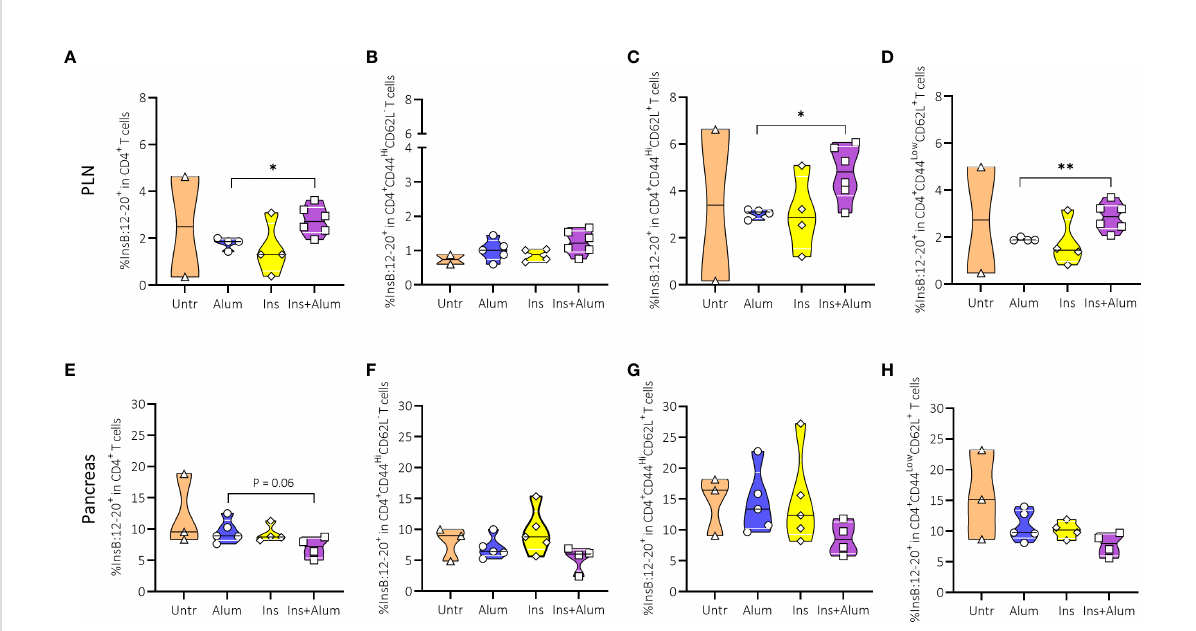
FIGURE 4 Effect of therapy on InsB:12-20-speci fi c CD4 + T cells and InsB:12-20-reactive effector memory, central memory, and naïve CD4 + T cells. Frequencies of InsB:12-20-reactive cells within the CD4 + T cell population (A, E) , CD44 high CD62L - (EM) CD4 + T cells (B, F) , CD44 high CD62L + (CM) CD4 + T cells (C, G) , and CD44 low CD62L + (naive) CD4 + T cells (D, H) are shown at 15 weeks of age in the PLN and pancreas of NOD mice. Female NOD mice received four weekly subcutaneous injections, from 10 until 13 weeks of age, of InsB:8-24 peptide formulated in alum (Ins +alum), InsB:8-24 peptide dissolved in buffer (Ins), alum alone (alum), or left untreated (Untr). Data presented as median with interquartile range; symbols (n = 2-6) represent individual mice. *P ≤ 0.05; **P ≤ 0.01; EM, effector memory; CM, central memory; NOD, non-obese diabetic; PLN, pancreas-draining lymph